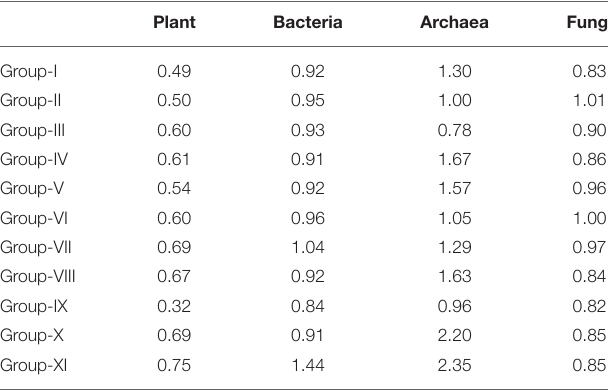
TABLE 3 | The species/genus-pair ratios of positive to negative association for plant and microbe in the reclaimed mining area. Plant Bacteria Archaea